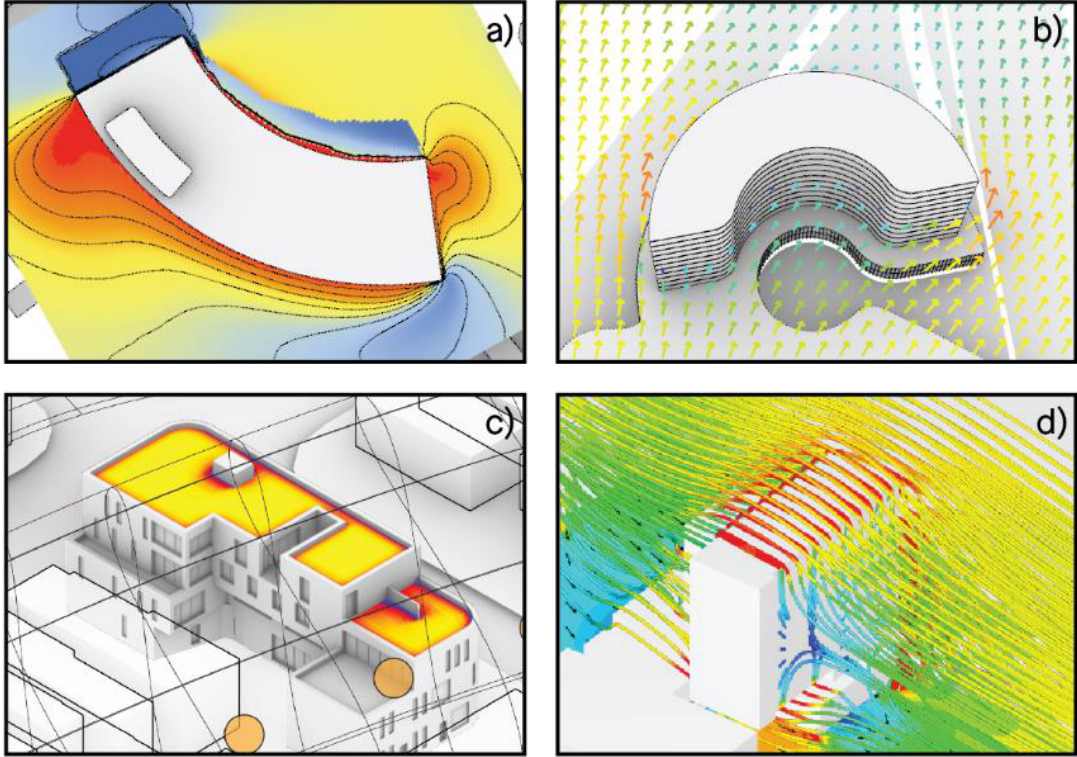
Figure 1. Screenshots of the outputs of environmental modelling tools: ( a ) ENVI-met, ( b ) Eddy3D, ( c ) Ladybug, and ( d ) SimScale.